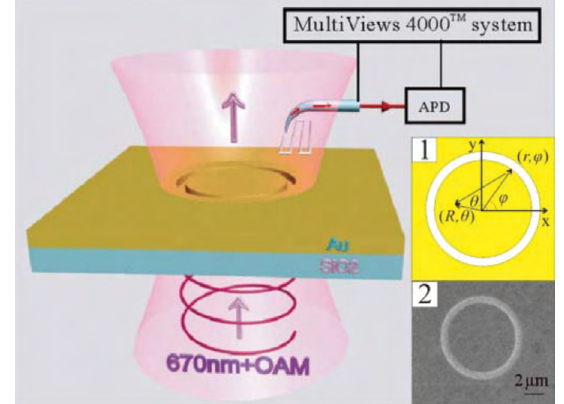
Figure 22 Schematic of the experimental setup. The plasmonic antenna is excited by LG mode from the substrate side and imaged by a NSOM probe. Inset 1 shows the diagram of a single ring plas- monic antenna. Inset 2 is the SEM image of the ring slot plasmonic antenna fabricated in gold film. Adapted from Ref. [49].